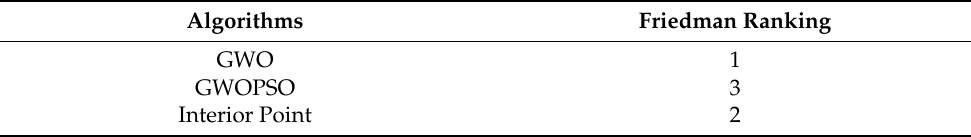
Table 10. Friedman Ranking test of GWO and other well-established